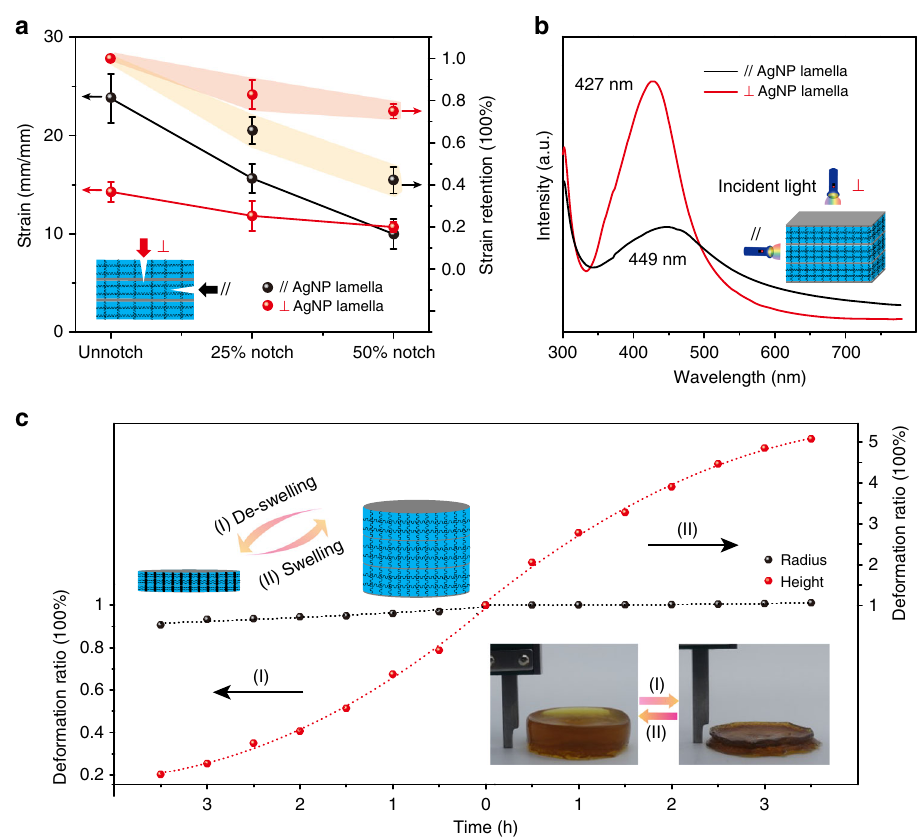
Fig. 4 Anisotropy on notch-insensitive, optical, and swelling performances. a Ball plot of SNPP hydrogel with notches parallel and perpendicular to AgNP lamella and notch ratios from 0 to 50%. Error bars show the SD with sample size of 3. b UV-vis spectra of SNPP hydrogel with the incident light from two orthogonal directions. c Deformation ratio pro fi les of radius and height of hydrogel against time during the de-swelling and swelling process. The inset images show the cycling between the initial and de-swollen